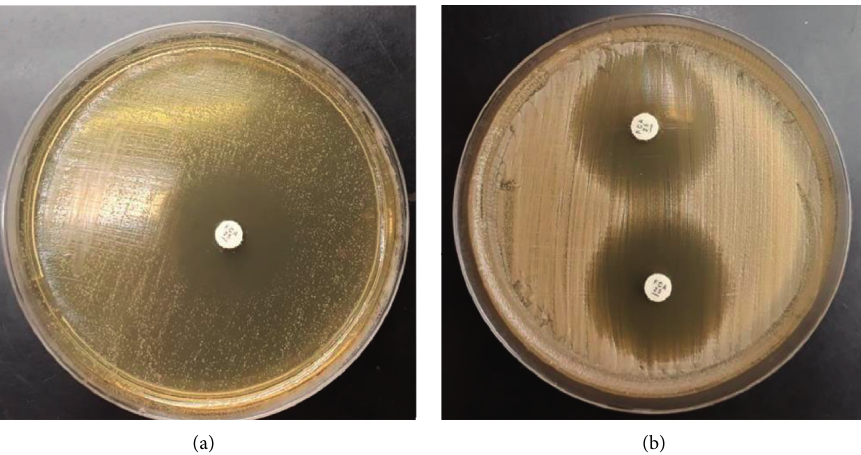
Figure 3: Comparison between standard disk diffusion (a) and rapid disk diffusion (b) susceptibility testing of Candida spp. for